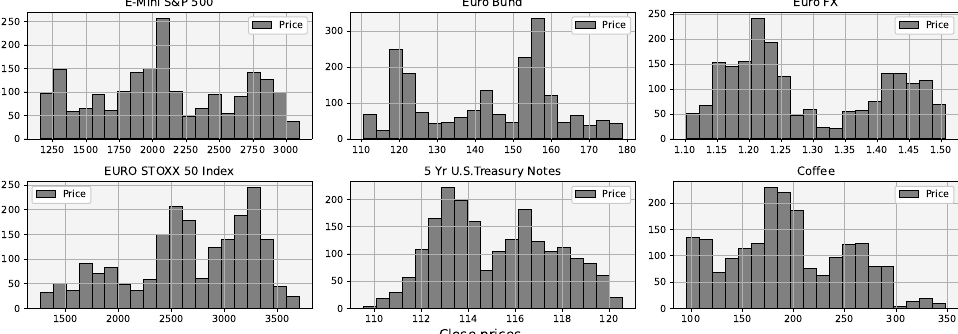
Figure 4. Distribution of selected non-stationary futures prices during an 8 year period. After the transformation to stationary prices, we can visually see the drastic change in their distributions in Figures 5 and 6.